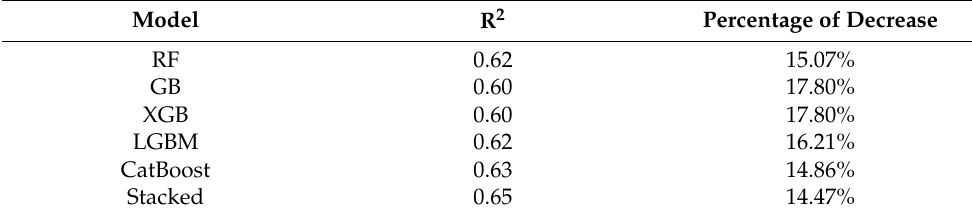
Table 8. The accuracy changes of the six models without NPP and climate